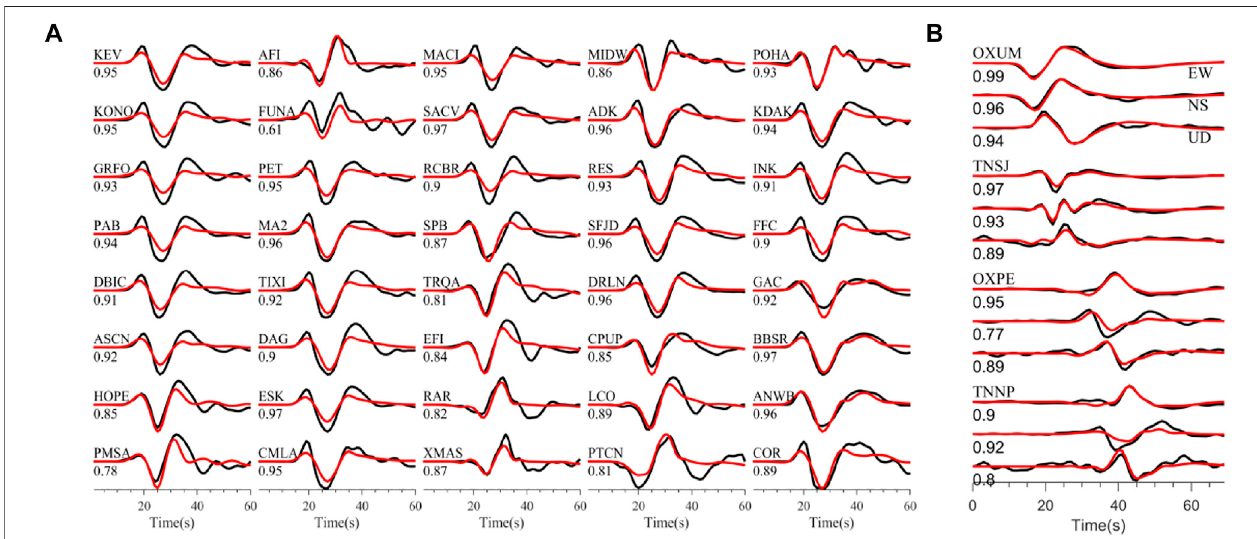
FIGURE 7 | Comparisons of the observed (black) and synthetic (red) waves. (A) Denotes the 40 teleseismic P waves ’ data. (B) Denotes the four high-rate GPS waves. The letters above the waves denote the station names and the digit under the waves denotes the correlation coef fi cient between the observed and synthetic waves.